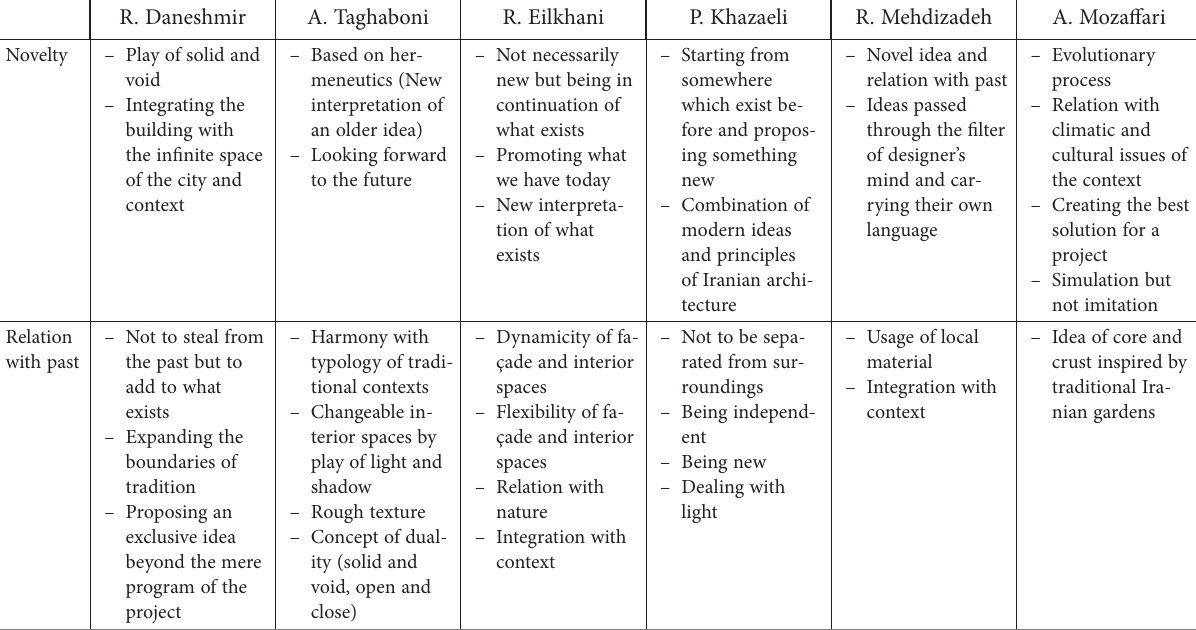
Table 7. Idea of each architect towards novelty and relation with